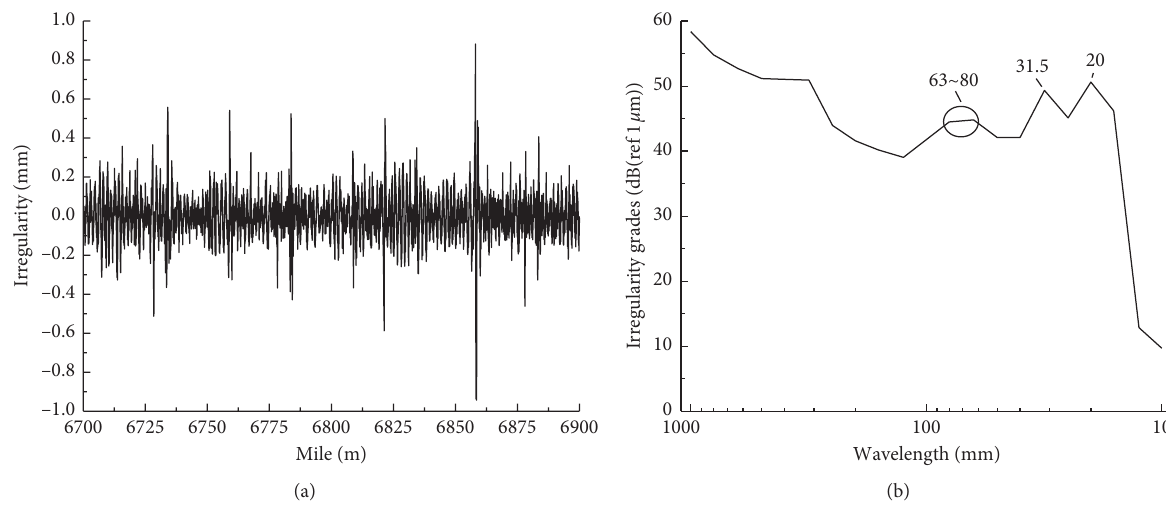
Figure 1: Measured corrugation. (a) Rail surface irregularity. (b) One-third octave wavelength spectrum of irregularity grades.